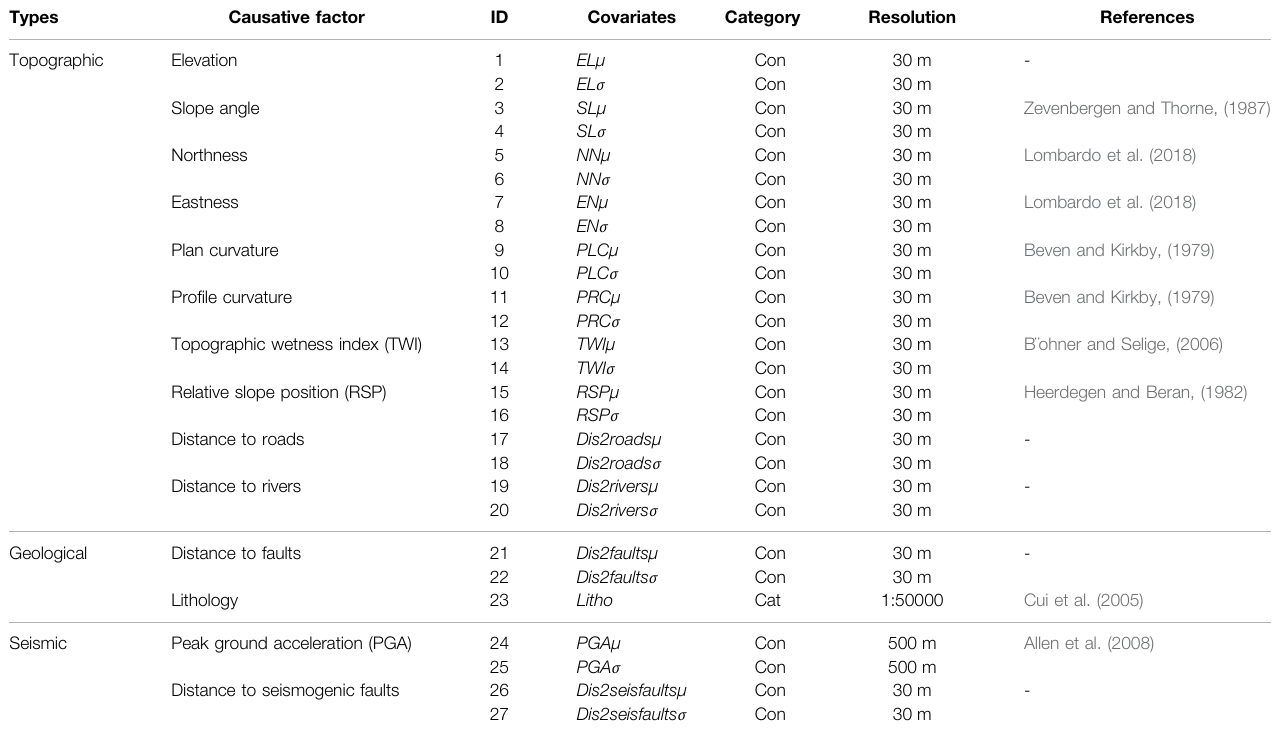
TABLE 3 | List of topographic, geologic, and seismic factors in the study area for the subsequent modeling procedure. Con or Cat indicates the continuous or categorical nature of the covariates.